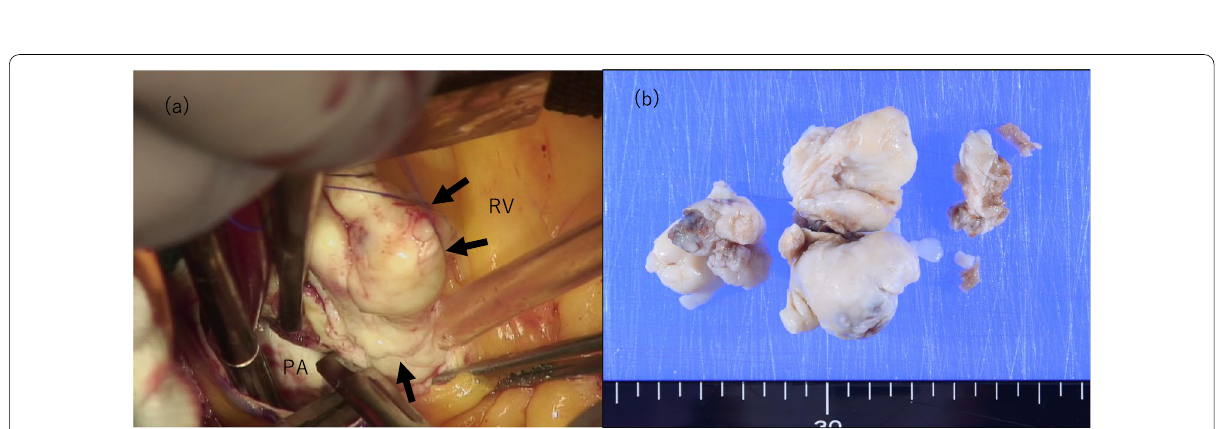
Fig. 2 Surgical findings. a Intraoperatively, the tumor (black arrow) is firmly lumped with the pulmonary valves and also partially extends to the posterior wall of the pulmonary artery. b Surgical